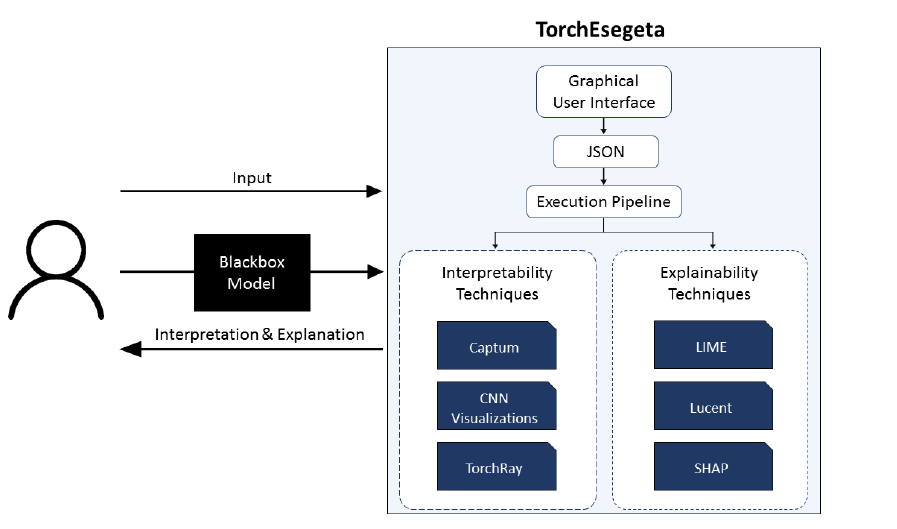
Figure 1. TorchEsegeta pipeline